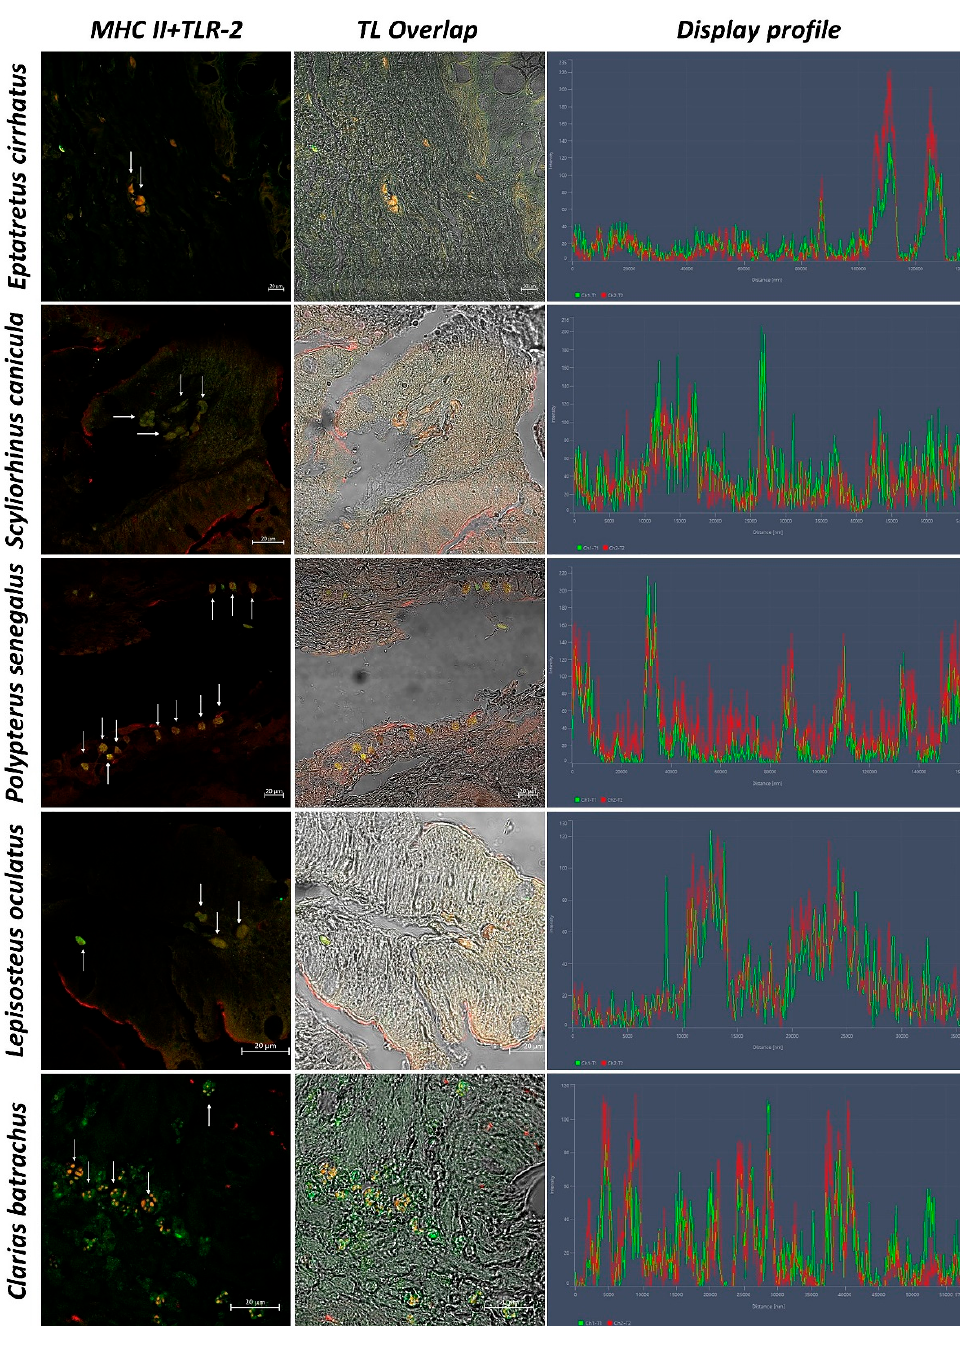
Figure 8. Colocalization of MHC II and TLR-2, 40 × , scale bar 20 µ m. The colocalization of MHC II (green) and TLR-2 (red) is evident (arrows). Overlap in Transmitted Light (TL) is used to compare the organ morphology. The “display profile” function was used to confirm the antibodies’